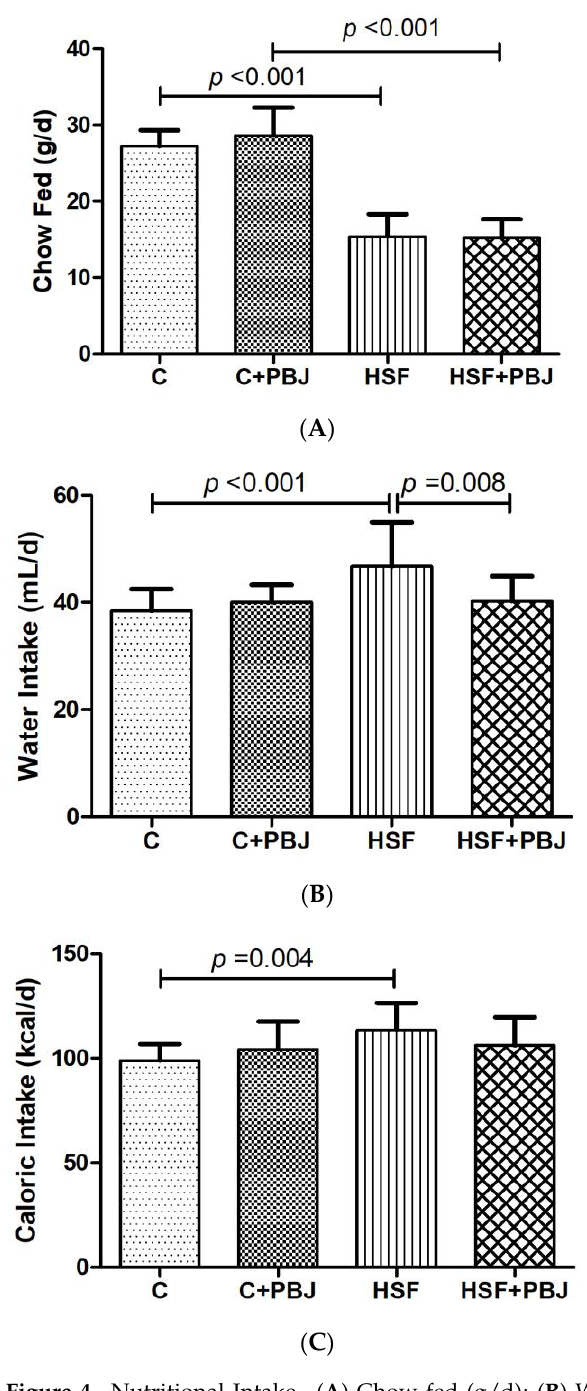
Figure 4. Nutritional Intake. ( A ) Chow fed (g/d); ( B ) Water intake (mL/d); ( C ) Caloric intake (kcal/d). The data are expressed as mean ± standard deviation (SD). Comparison by two-way ANOVA with Tukey’s post-hoc. C—Control diet + placebo; HSF—High-sugar, high-fat diet; p < 0.05 as significant .